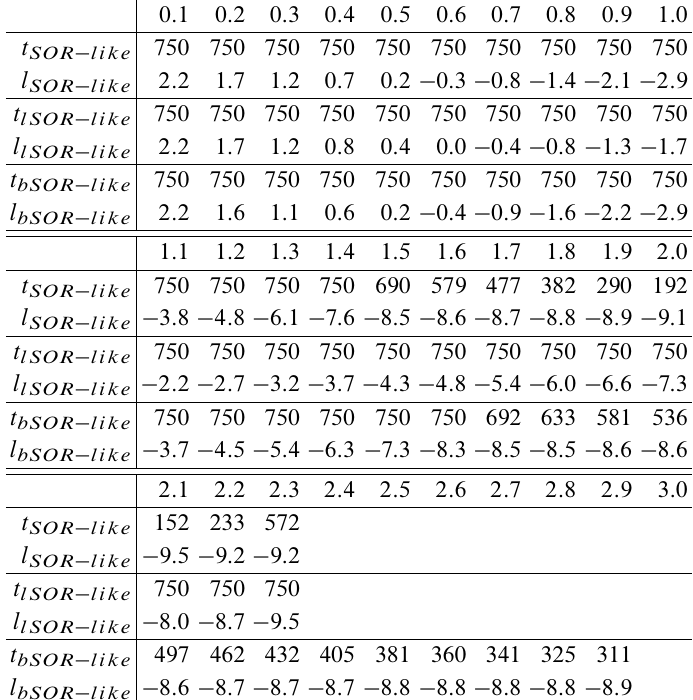
Table 2. SOR-like: numbers of iterations for tested ! , .˛ D (cid:0) 5/